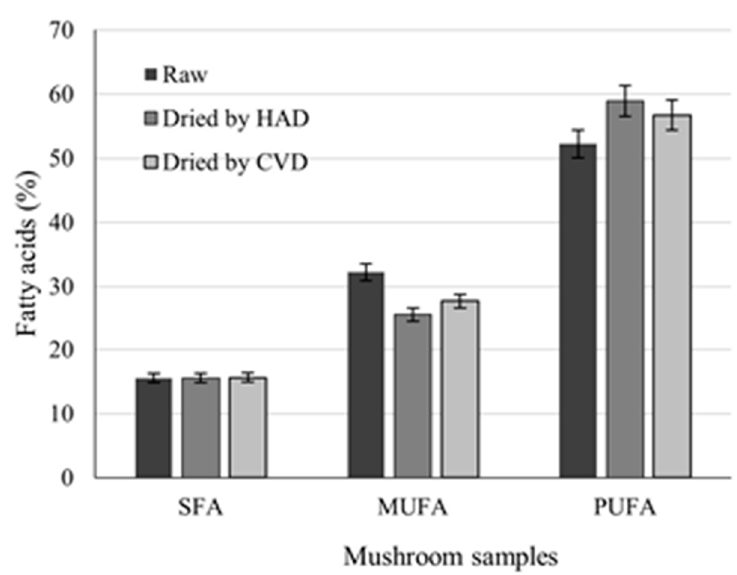
Figure 2. Total content of saturated, monounsaturated, and polyunsaturated fatty acids of raw and dried B. edulis according to different drying procedures.